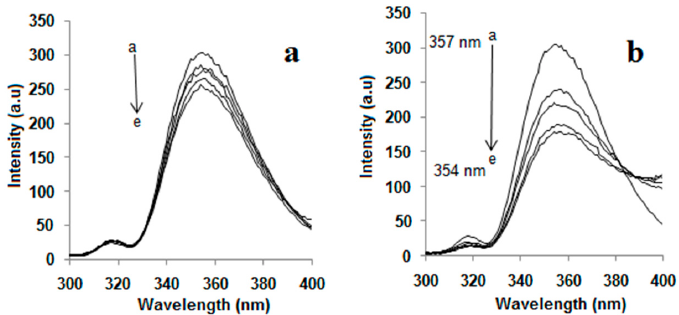
Figure 5. Fluorescence spectra of NAP in the presence of ( a ) 2 and ( b ) 1a , T = 298 K, [NAP] = 1 × 10 − 6 mol/L = constant. ( a ) 2 (10 − 6 mol/L): (a) 0, (b) 8.0, (c) 7.0, (d) 5.0, (e) 4.0; ( b ) 1a (10 − 6 mol/L): (a) 0, (b) 8.0, (c) 7.0, (d) 5.0, (e) 4.0.